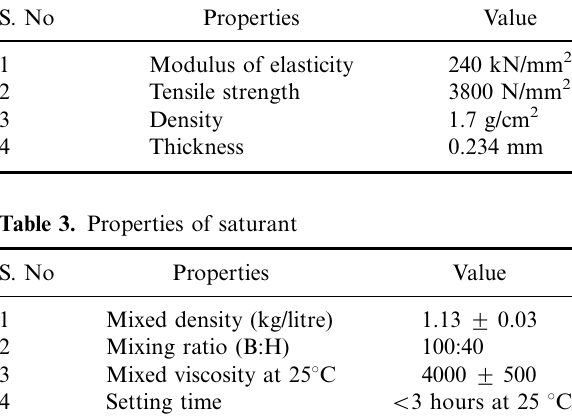
Table 2. Properties of carbon fiber S. No